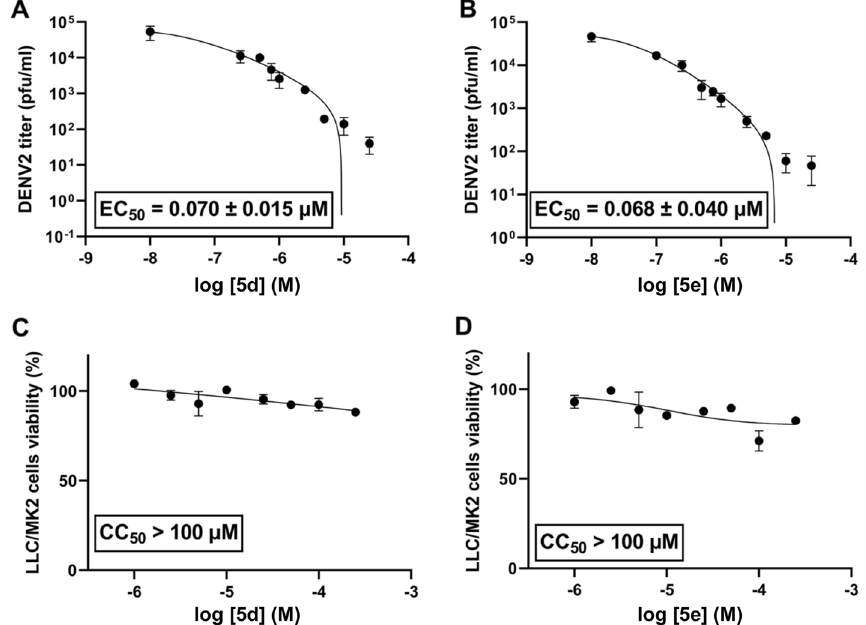
Figure 3. ( A , B ) efficacy of 5d and 5e against DENV2-infected LLC/MK2 cells, and ( C , D ) their cytotoxicities. Errors were calculated from three independent experiments.